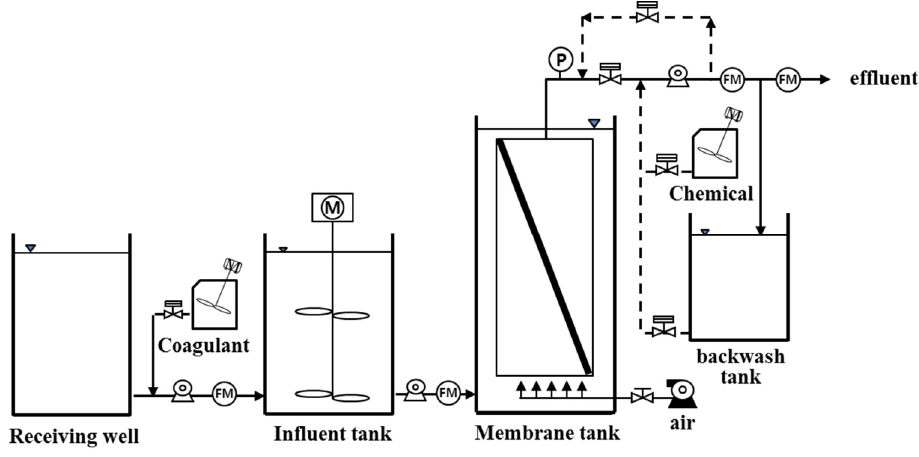
Figure 1. Schematic diagram of pilot-scale plant used in this study.